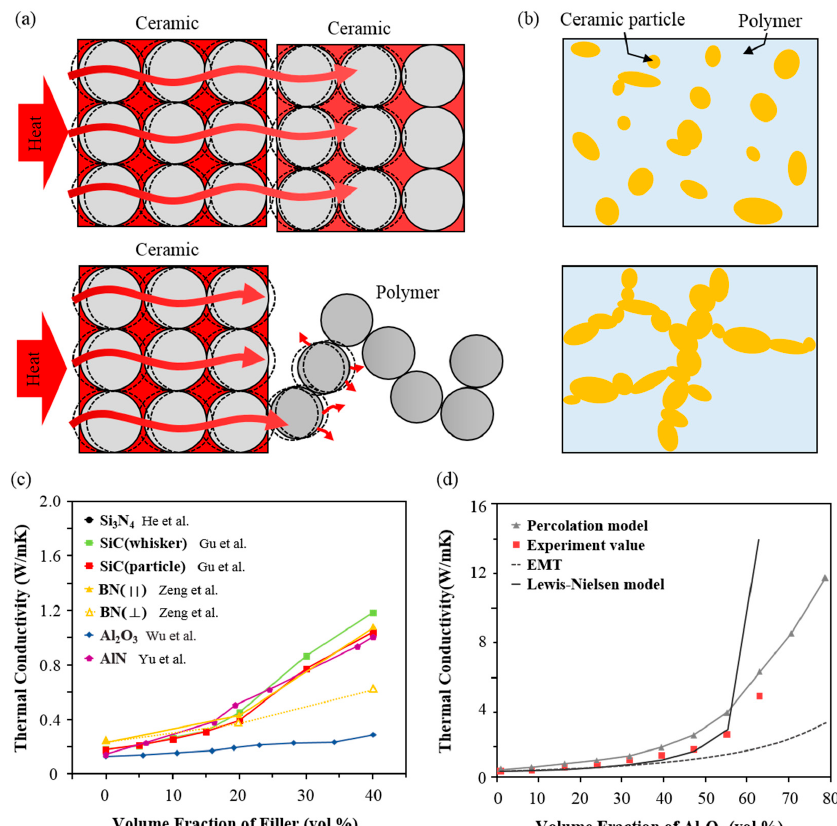
Figure 2. ( a ) The thermal conductive mechanism in ceramic-ceramic (upper) and ceramic-polymer (lower). ( b ) Scheme of a randomly dispersed ceramic-polymer composite with below (upper) and above (lower) the percolation threshold volume fraction of filler. ( c ) Comparison of thermal conductivities with randomly dispersed various composites and their volume ratio effects [3,22,35,45,50]. ( d ) Comparison between several simulated fittings of thermal conductivity based on theories and experimental values for randomly dispersed Al 2 O 3 filler-polymer composite [51]. Reprinted with permission from [51] Copyright (2000) IEEE.